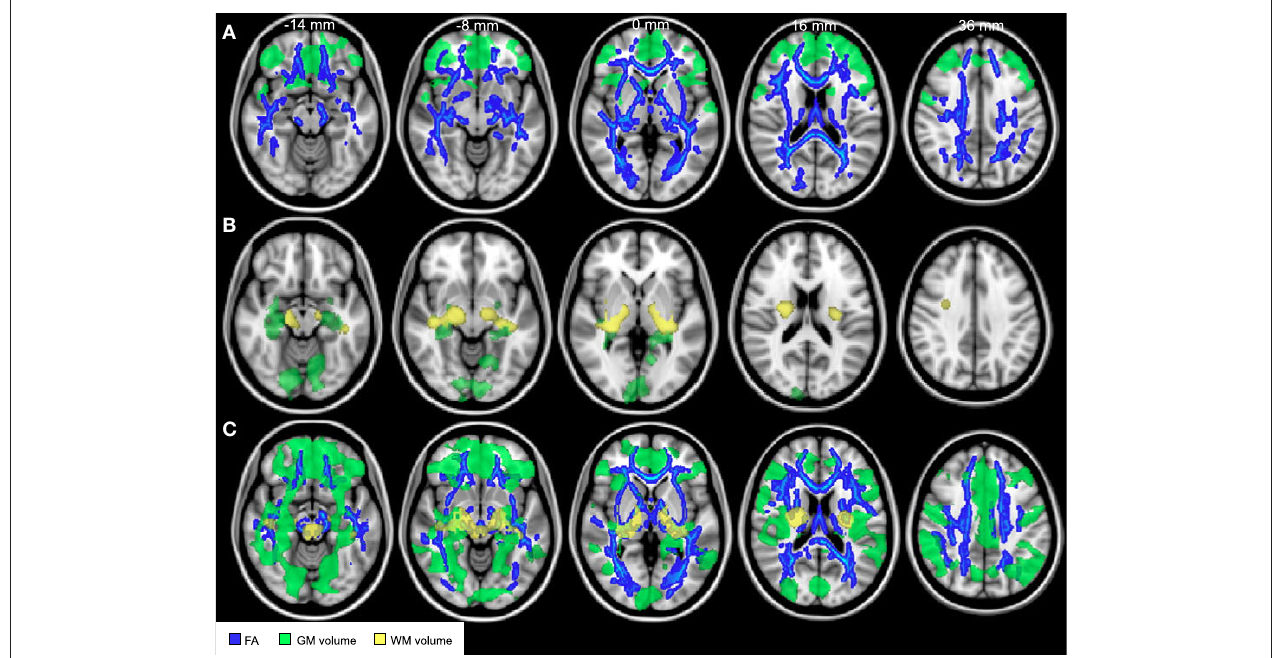
FIguRe 1 | Structural brain changes with age. Comparisons of fractional anisotropy (blue), gray matter volume (green), and white matter volume (yellow) between young (aged 23–40 years), middle-aged (aged 41–60 years), and older (aged 60–82 years) adults. (A) Comparisons between the young and middle- aged groups revealed widespread reductions in fractional anisotropy and